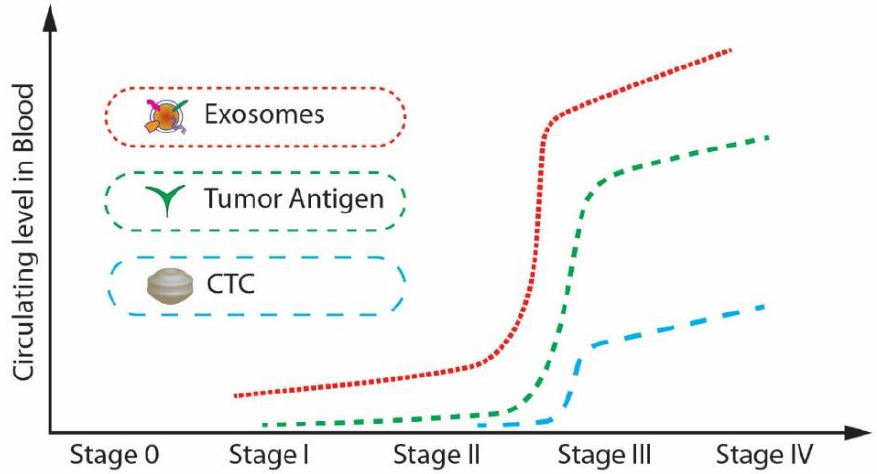
Figure 2. The circulating levels of tumour antigens, CTCs, and exosomes in blood during cancer progression. (Modified from He M., Zeng Y. [32]. Copyright 2016, J Lab Autom).